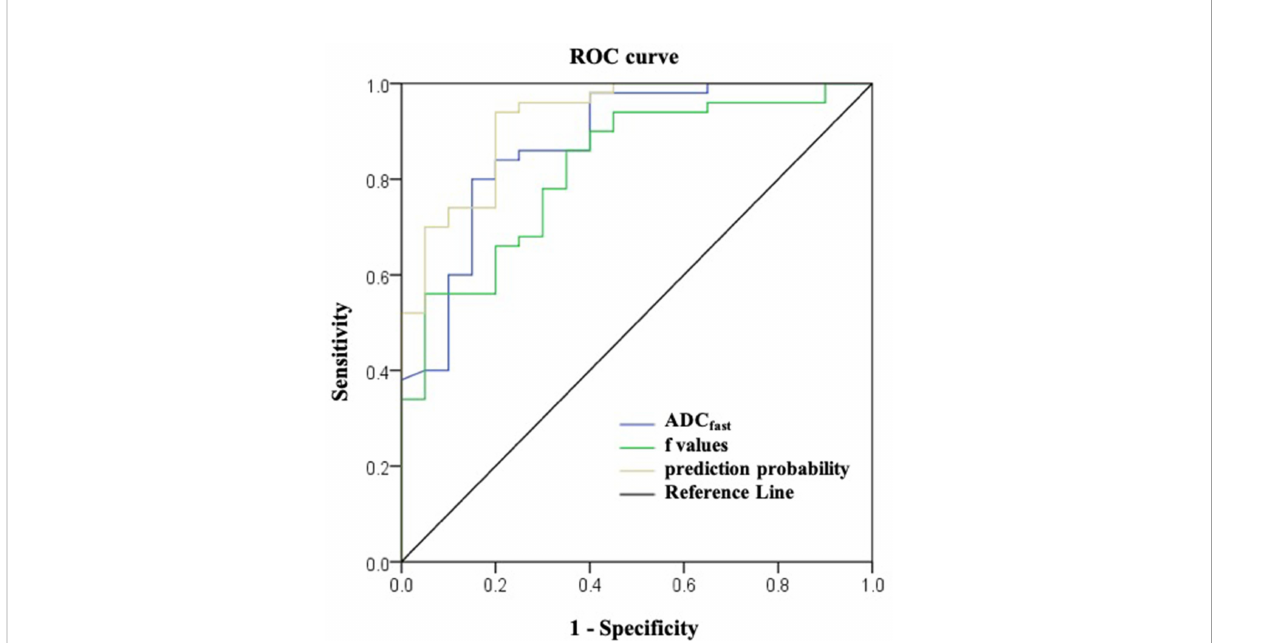
FIGURE 3 ROC curves to differentiate tuberculous spondylitis and spinal